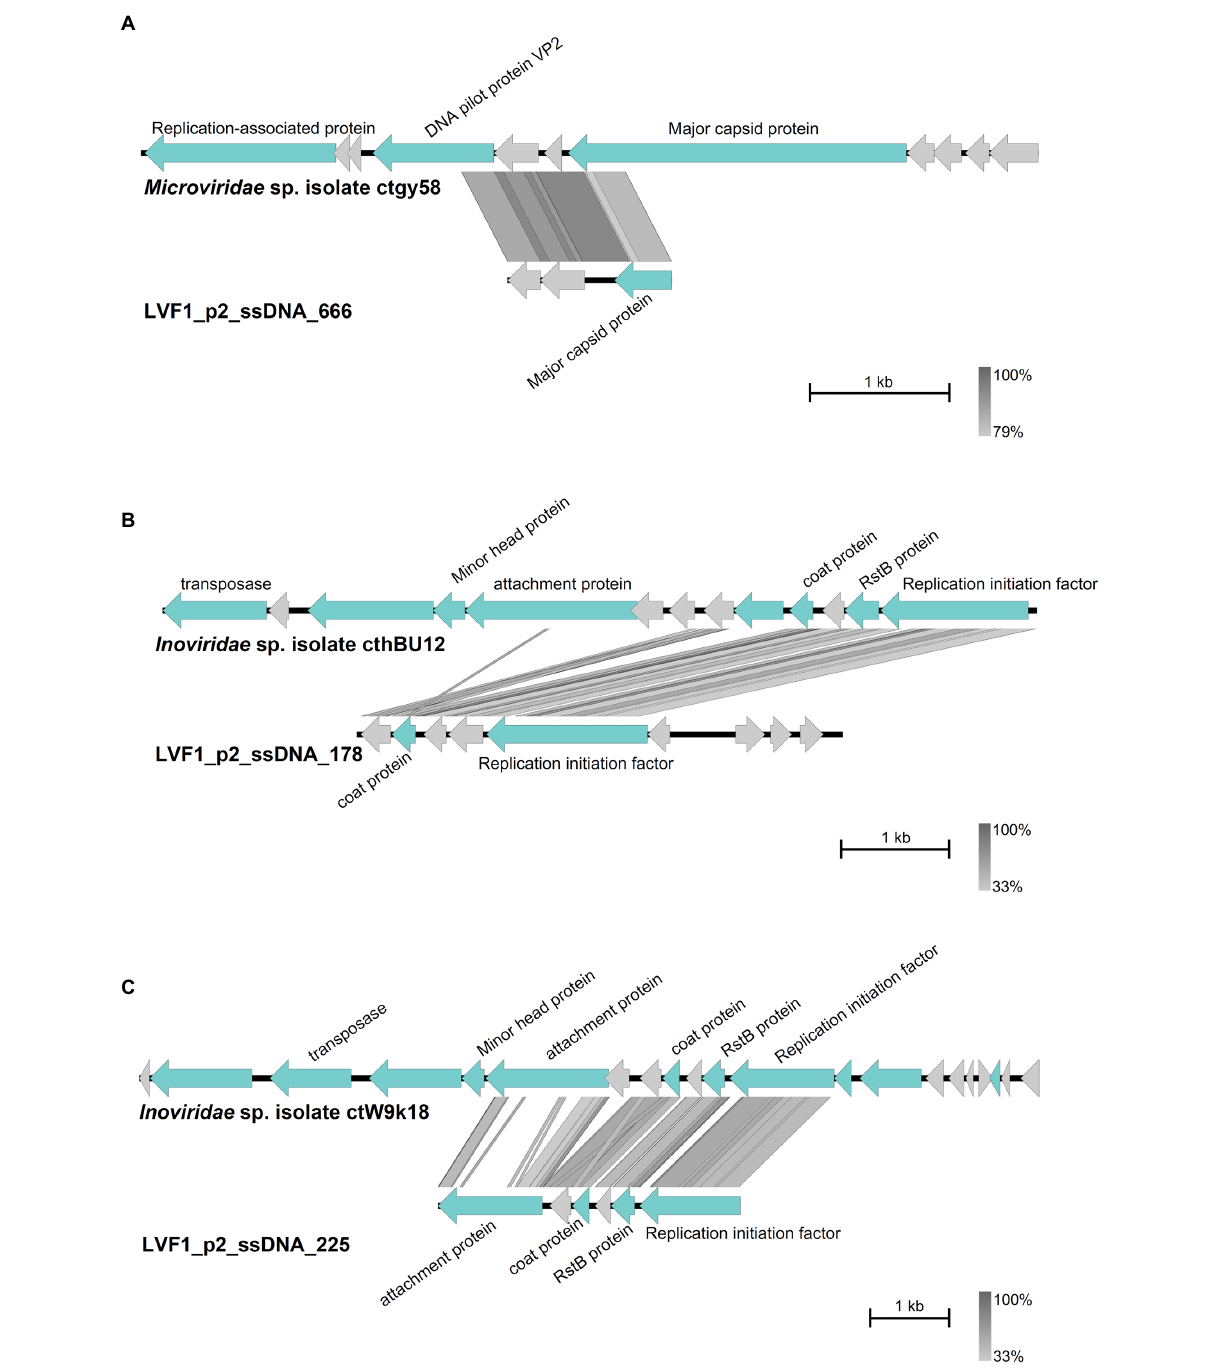
FIGURE 5 Comparison of the contigs with best Blastn matches. Arrow indicates gene direction. Phage-specific gene products are shown in light blue with corresponding labeling, hypothetical proteins in light grey. Comparison of (A) contig 666 with Microviridae sp. isolate ctgy58, (B) contig 178 with Inoviridae sp. isolate cthBU12 and (C) contig 225 with Inoviridae sp. isolate ctW9k18. Plot was created with Easyfig (Sullivan et al.,